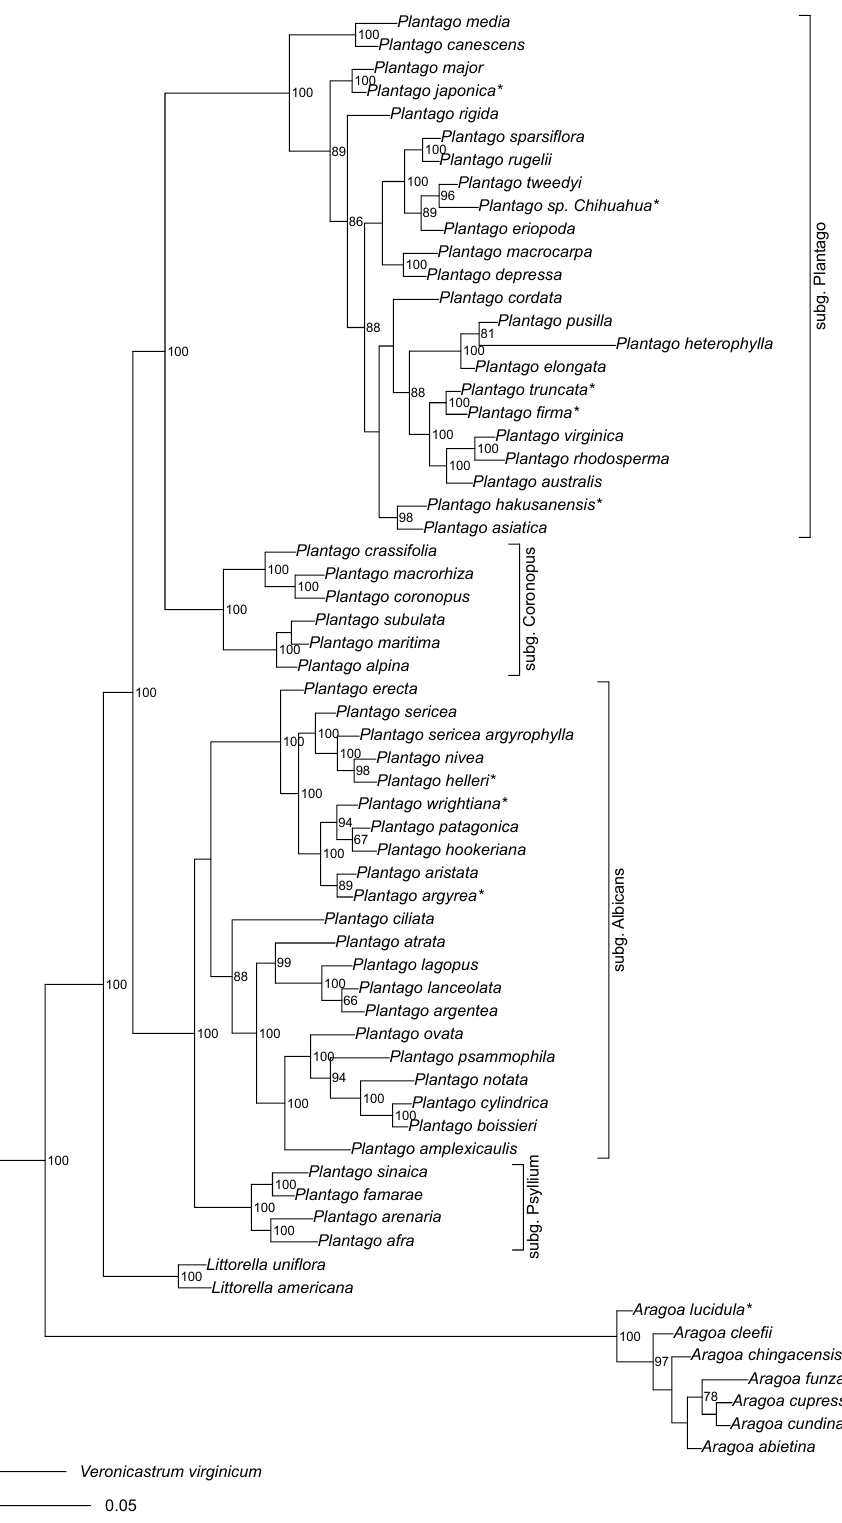
Figure 4. The phylogeny of Plantagineae obtained from the “broad” dataset (based on MB trees). Stars (*) mark species which have not been barcoded before. Numbers on nodes are Bayesian posterior probabilities (%). Names started with “subg.” are subgenera of Plantago